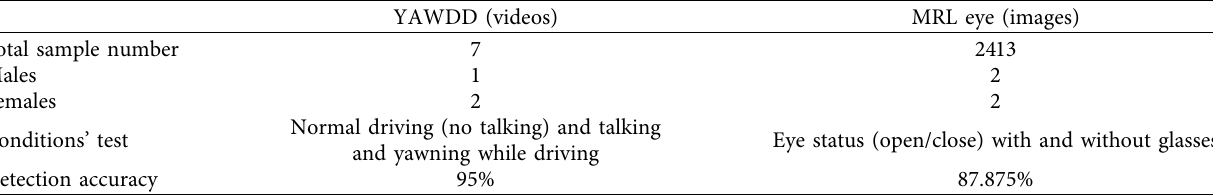
Table 7: Online YAWDD videos’ dataset MRL eye image dataset